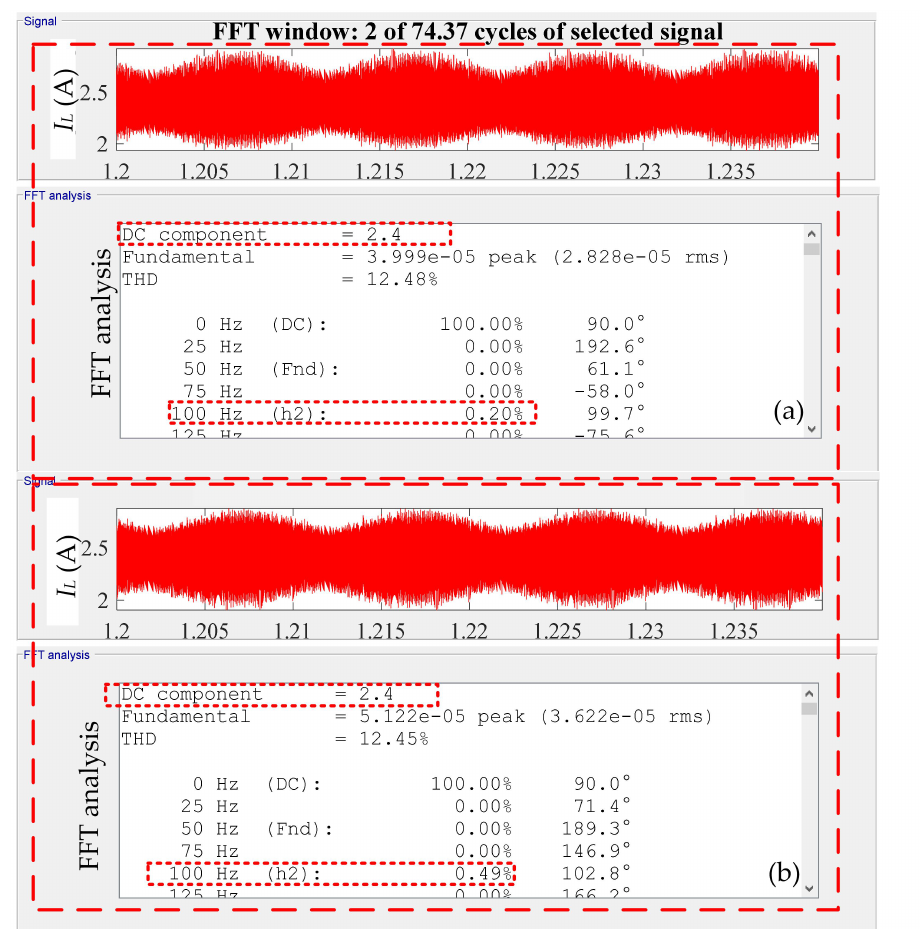
Figure 13. Inductor current when the harmonic source is placed at the output and GCF = 8.33 kHz: ( a ) PI controller and ( b )